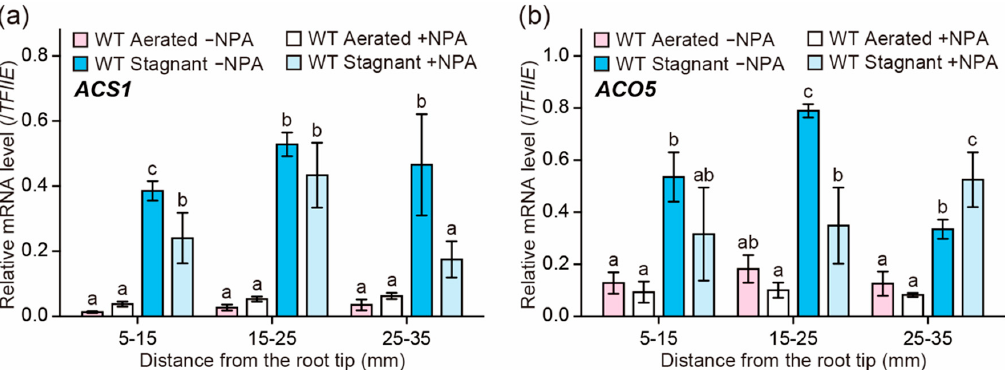
Figure 5. Expression of ethylene biosynthesis genes in adventitious roots under aerated or stagnant conditions with or without N -1-naphthylphthalamic acid (NPA) treatment. Twenty-day-old aerobically grown wild type (WT) seedlings were further grown under aerated or stagnant conditions with or without 0.5 µ M NPA for 48 h. Relative transcription levels of ACS1 ( a ) and ACO5 ( b ) at 5–15, 15–25, and 25–35 mm from the tips of adventitious roots. The gene encoding transcription initiation factor IIE (TFIIE) was used as a control. Different lowercase letters denote significant differences among the conditions ( p < 0.05, one-way ANOVA followed by Tukey’s test for multiple comparisons). Values are means ± SD ( n = 3).